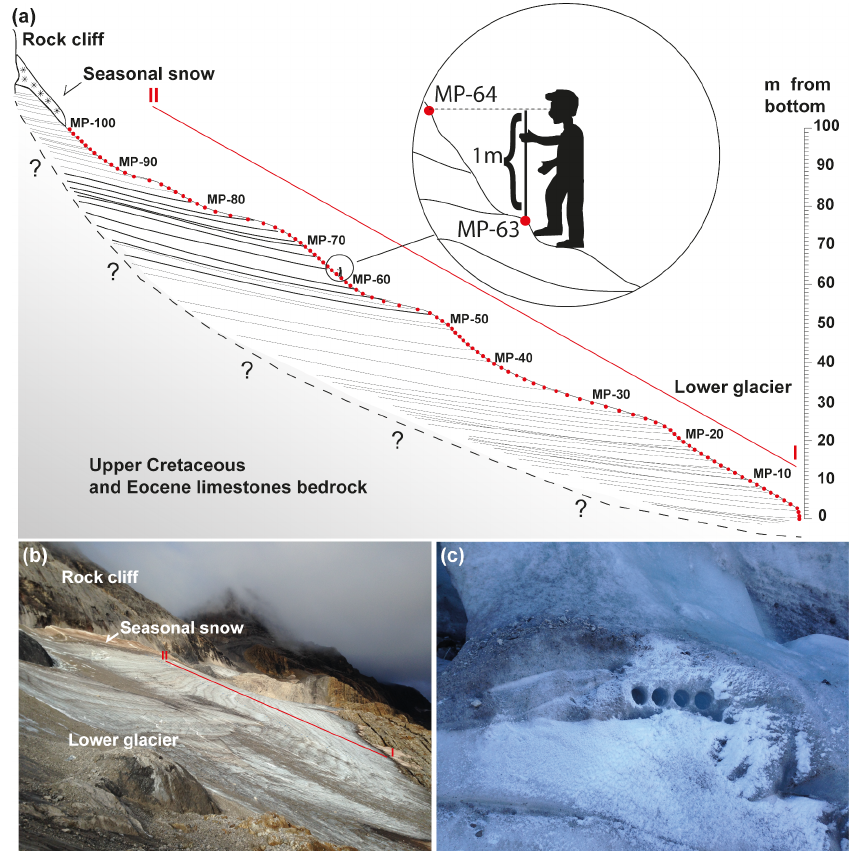
Figure 2. (a) Simplified scheme with the position of the 100 samples collected along the slope (red line I–II marks the profile indicated in panel b ; identification of the samples is MP-0 to MP-100). According to the ice bedding (tilt is approximate) the oldest material should be found at the bottom of the lower glacier. The number of glacier layers is drawn according to the layers observed in the image depicted in panel (b) . Note the inset with a detailed view of the sampling procedure measuring a height difference of 1m to obtain every sample. (b) Image of the Monte Perdido glacier surface where the sampling was carried out (red line I–II represents the sampled profile shown in Fig. 1). Note the presence of dark debris-rich layers alternating with cleaner ice. (c) Detailed view indicating that every sample consisted of three to four small horizontally drilled cylinders (see text for more